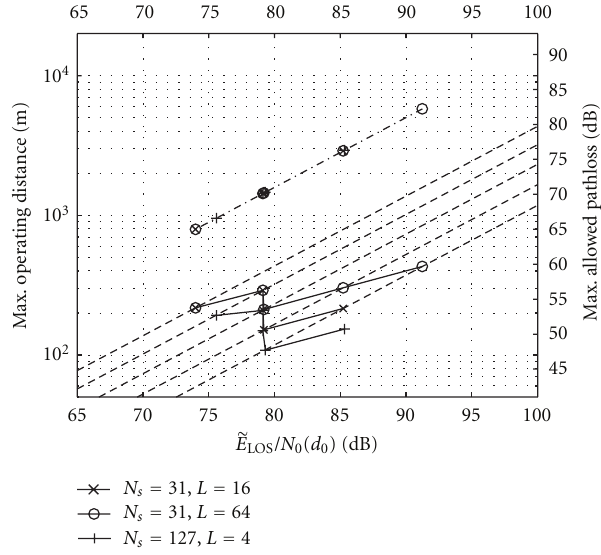
Figure 5: Achievable preamble energies. Figure 6: Code sequence analysis on the maximal operating distance and the maximal allowed pathloss, where the solid lines correspond to the energy detector, the dashed-dotted lines belong to the coherent receiver, and the dashed lines indicate constant noise dimensionality for the energy detector. The values are given for N pr = [16,64,256,1024,4096] (from left to